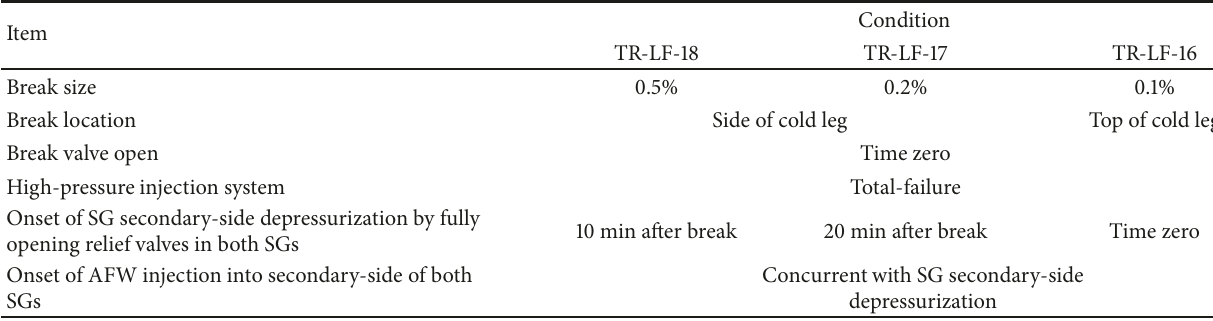
Table 1: Major conditions of LSTF tests.